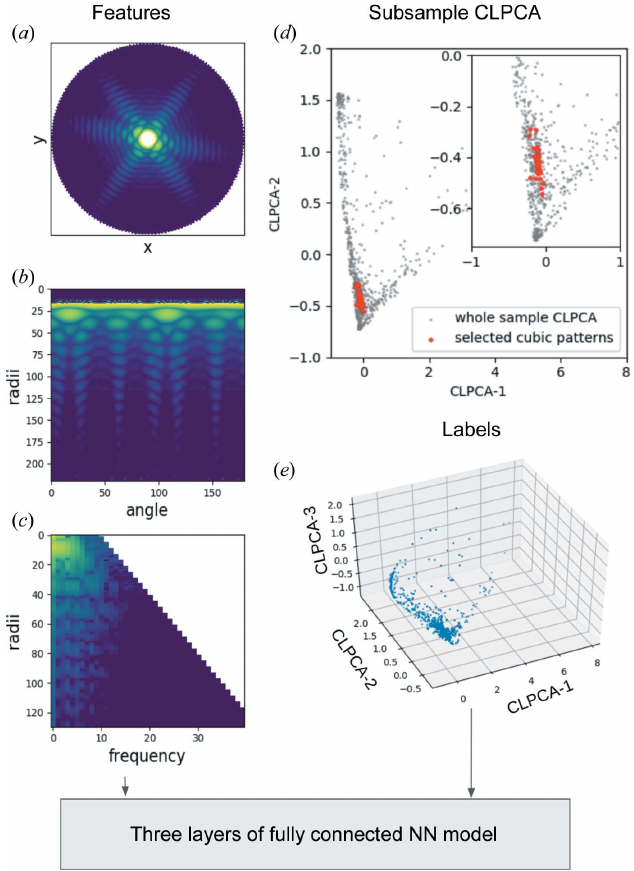
Figure 3 A brief illustration of the absolute embedding neural network (NN) model. ( a ) The average pattern from Dragonfly . ( b ) A polar representa- tion of the pattern. ( c ) A stack of 1D Fourier transform magnitudes along the angular axis for each radial bin. The odd frequency components (due to inversion symmetry) and the higher frequencies for signals at smaller radii have been removed. These represent the feature vectors for the neural network. ( d ) An example of using absolute CLPCA on a selected cubic subset of frames (red dots). The grey dots represent the embedding of the pattern averages from the whole dataset. ( e ) Training labels from